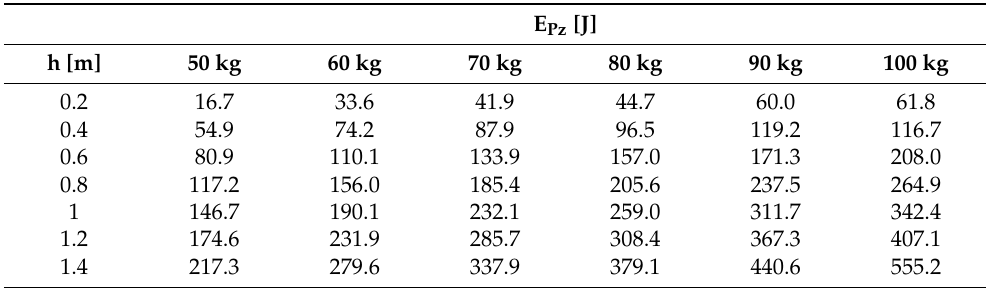
Table 2. Values of residual positional energies E Pz for individual measurements with the spherical impactor.